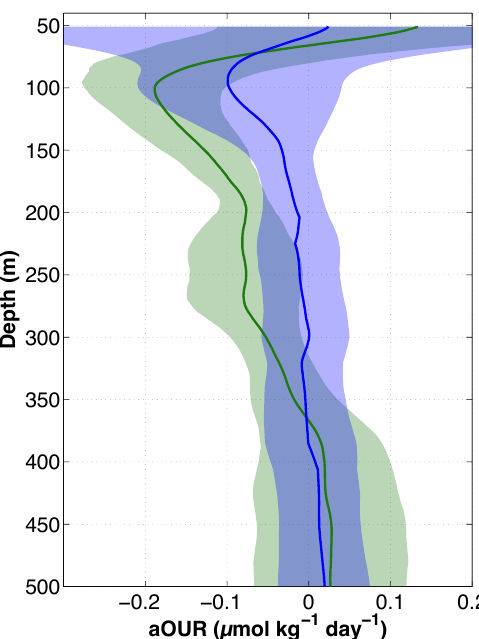
Figure 7. Depth profiles of a mean apparent oxygen utilization rate (aOUR, µmolkg − 1 d − 1 ) within CEs (blue) and ACMEs (green) in the ETNA with associated standard deviation (shaded area). De- rived by using the propagation time of each eddy, an initial coastal oxygen profile and the assumption of linear oxygen consumption (based on depth